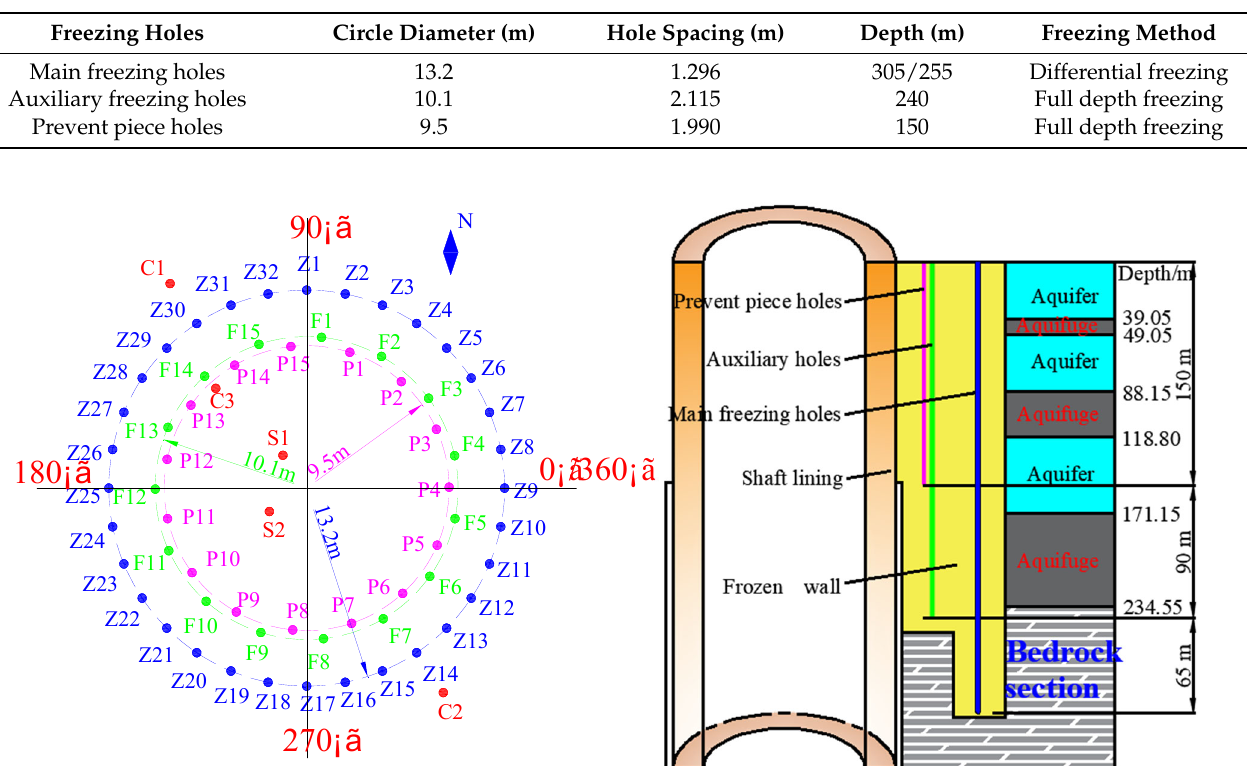
Table 1. Parameters of the freezing holes.